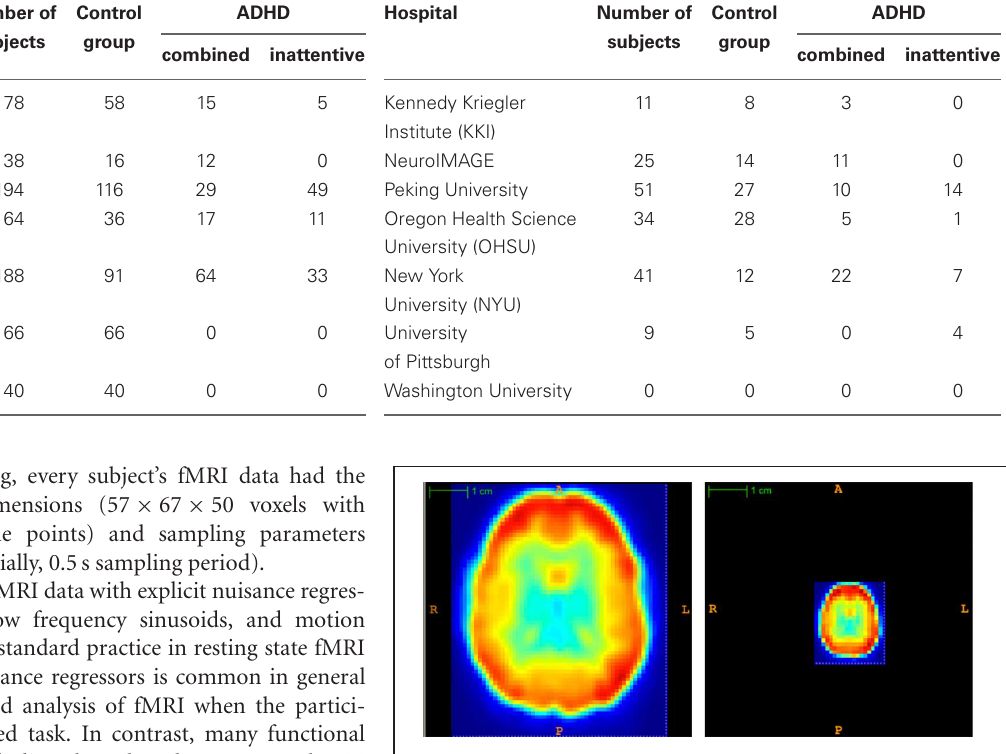
FIGURE 3 | Temporal view of subject’s original (left) and averaged (right) volume at time point t = 1. Averaging reduced the spatial dimensionality by a factor of 3 × 3 × 3 =